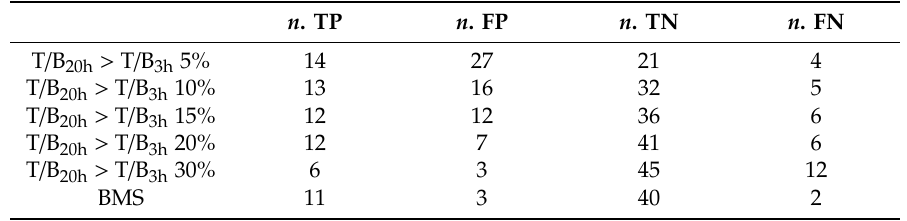
Table 3. Number of true positive, false positive, true negative and false negative patients detected by semi-quantitative analysis and BMS.